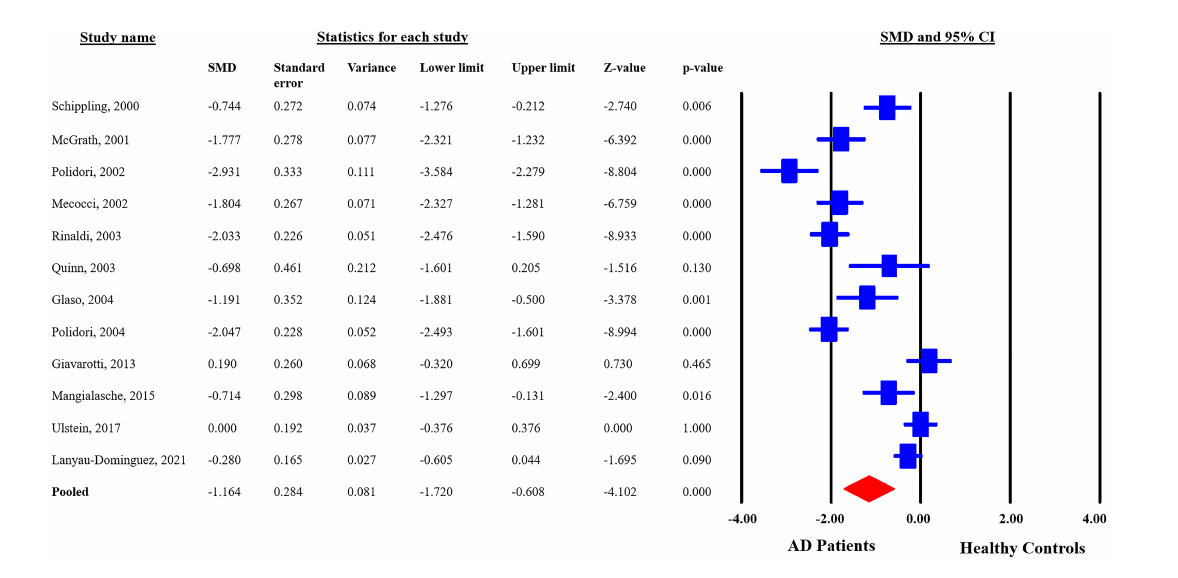
FIGURE3 Forest plot for plasma concentrations of vitamin C in Alzheimer’s disease (AD) patients and healthy controls. CI, confidence interval; SMD, standardized mean difference.